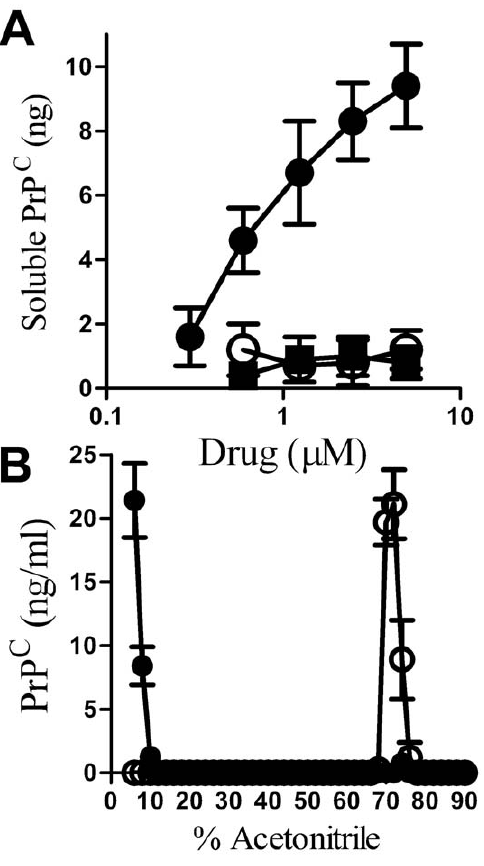
N ), glibencla- Figure 3. Glimepiride released PrP C from cortical neurones. (A) N The amount of PrP C in the supernatant of cortical neurones treated for ), glibenclamide 1 hour with different concentrations of glimepiride ( ( # ) or glipizide ( & ). Values shown are the mean average amount of soluble PrP C (ng/10 6 cells) 6 SD, n=9. (B) The amount of PrP C molecules eluted from C18 columns following elution with a gradient of acetonitrile in water containing 0.1% TFA. Fractions eluted from C18 N columns loaded with whole cell extracts ( # ) or with supernatants from ). Values shown are cortical neurones treated with 5 m M glimepiride ( the mean average amount of PrP C (ng/ml) 6 SD,